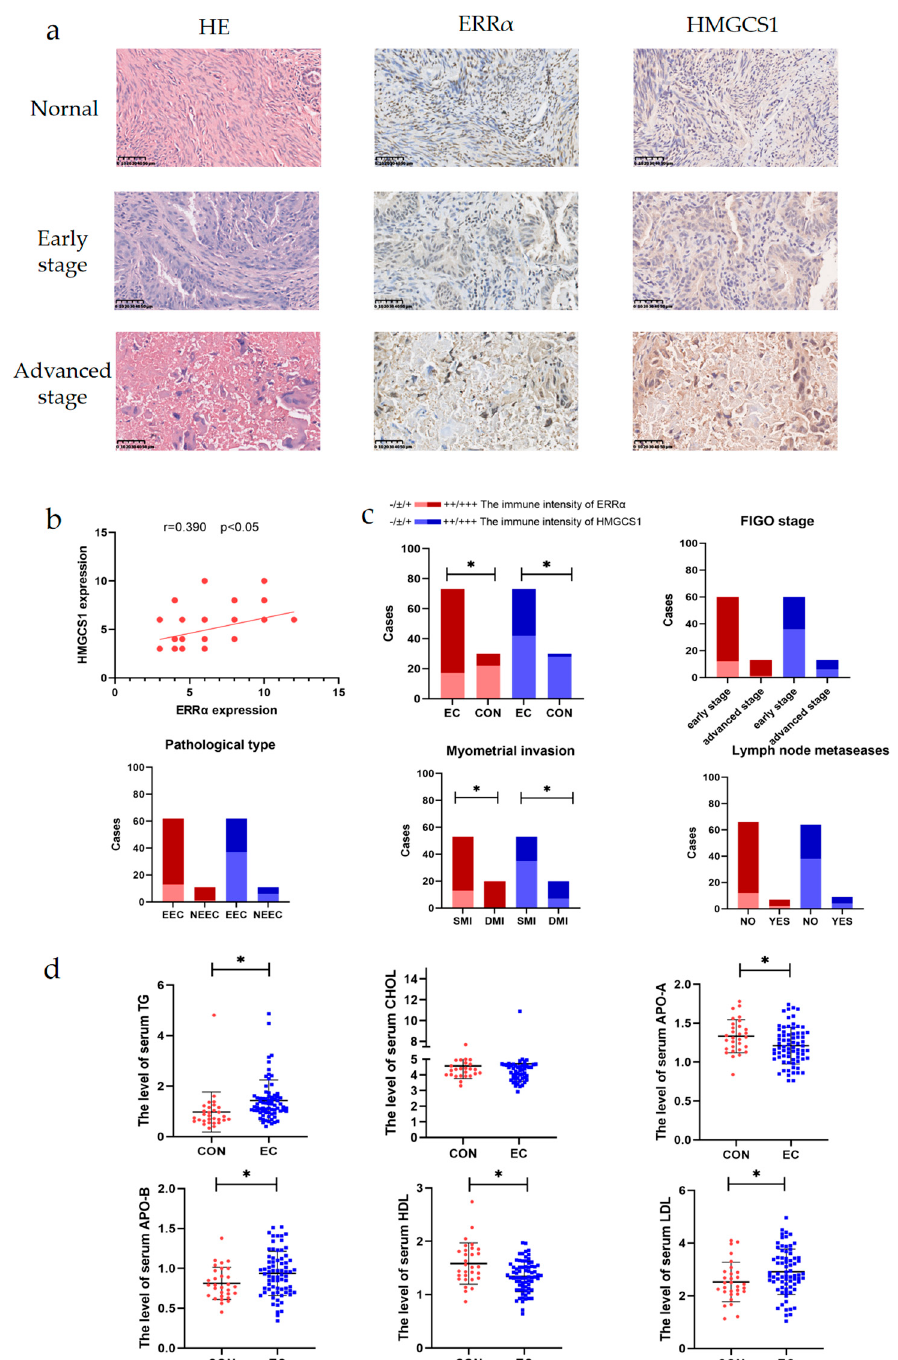
Figure 2. ERR α and HMGCS1 are highly expressed in the tissues of patients with EC and are associated with metastasis. ( a ) The expression of ERR α and HMGCS1 in EC tissues at different International Federation of Gynecology and Obstetrics (FIGO) stages and control endometrial tissues (magnification, 400 × ; scale bars, 50 µ m). ( b ) the correlation analysis of between ERR α and HMGCS1 expression levels of EC patients. ( c ) Analysis of ERR α and HMGCS1 and histopathological characteristics. ( d ) Differences in the serum levels of TG, cholesterol (CHOL), APO-A, APO-B, HDL, and LDL in healthy control patients and patients with EC. *, indicates statistical significance. Statistical tests: Student’s t-test and Pearson’s rank correlation analysis.